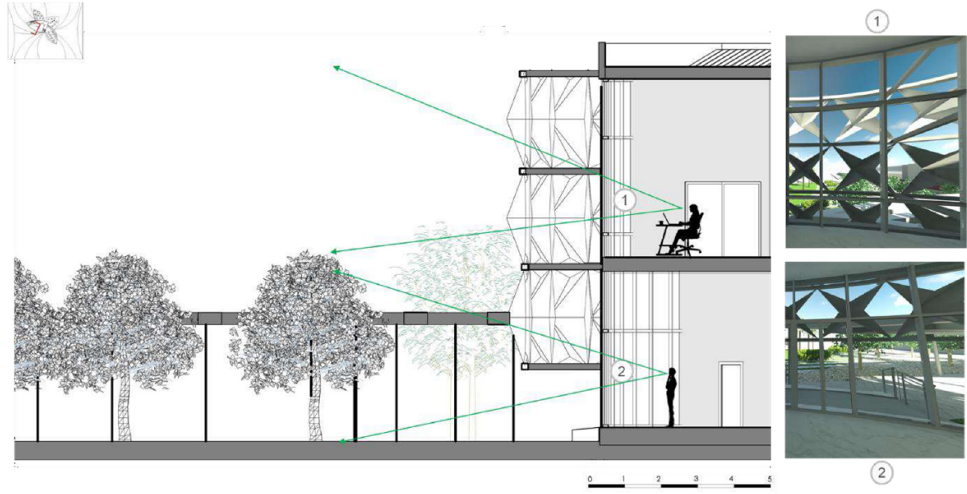
Figure 21. Visual connection indoor–outdoor.